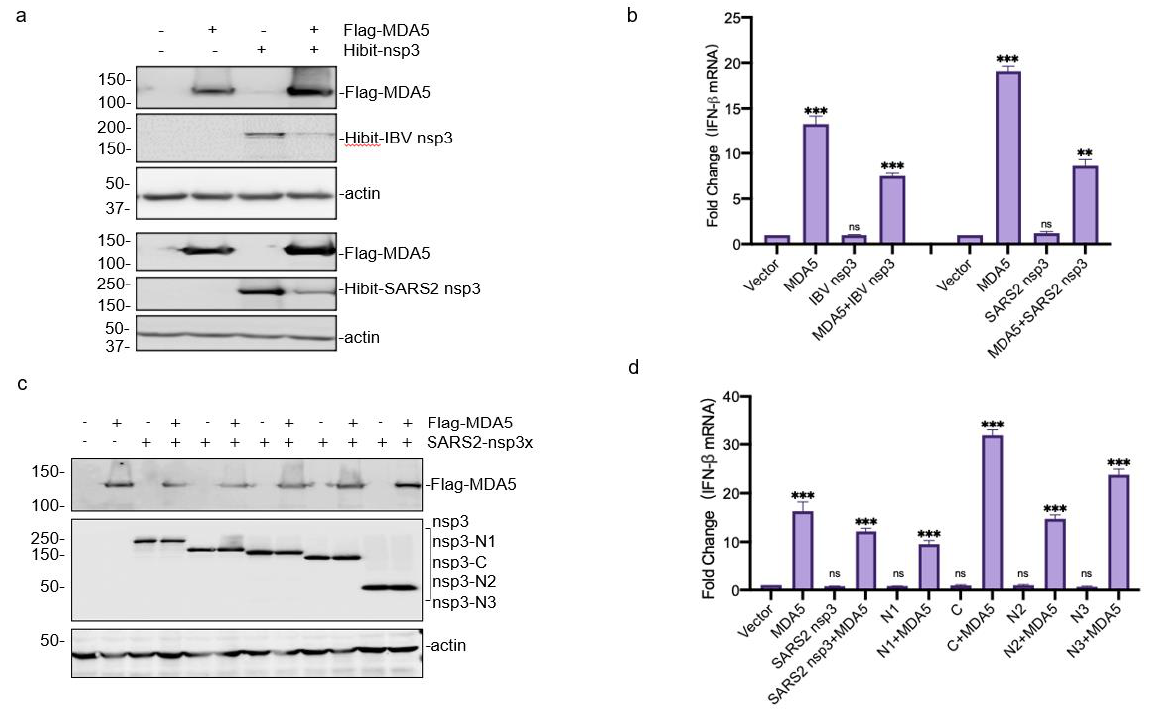
Figure 4. Suppression of the MDA5-mediated IFN- β induction by SARS-CoV-2 and IBV nsp3. ( a ) Western blot analysis of the expression of Flag-MDA5 co-transfected with Hibit-tagged SARS- CoV-2 or IBV nsp3. HEK293T cells were transfected either with Flag-MDA5 alone or together with Hibit-tagged SARS-CoV-2 or IBV nsp3. Cells were harvested at 24 h post-transfection and subjected to Western blot analysis with anti-FLAG and anti-Hibit antibodies, respectively. Beta-actin was included as the loading control. Sizes of protein ladders in kDa are indicated on the left. ( b ) Suppression of the MDA5-mediated IFN- β induction by SARS-CoV-2 and IBV nsp3. Total RNA was extracted from cells harvested in ( a ), and the IFN- β levels were determined by RT-qPCR after normalization with the GAPDH mRNA extracted from cells transfected with the empty vector. Significance levels were presented by the p -value (ns, non-significance, **, p < 0.01; ***, p < 0.001). ( c ) Western blot analysis of the expression of Flag-MDA5 co-transfected with Hibit-tagged full-length or truncated SARS-CoV-2 nsp3. Cells were harvested at 24 h post-transfection and subjected to Western blot analysis with anti-FLAG and anti-Hibit antibodies, respectively. Beta-actin was included as the loading control. Sizes of protein ladders in kDa are indicated on the left. ( d ) Effects of co-expression of MDA5 and the full-length or truncated SARS-CoV-2 nsp3 on the MDA5-mediated IFN- β induction. Total RNA was extracted from cells harvested in ( c ), and the IFN- β levels were determined by RT-qPCR after normalization with the GAPDH mRNA extracted from cells transfected with the empty